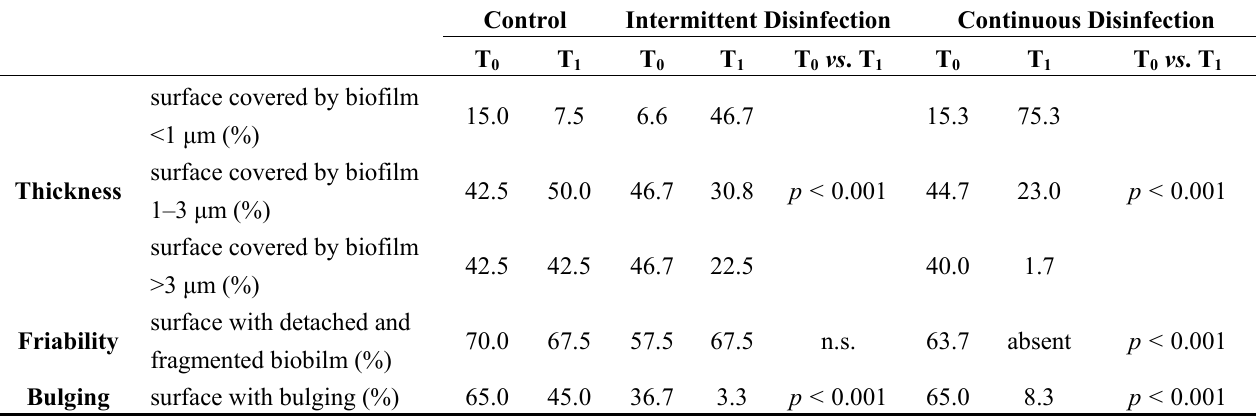
Table 3. Characteristics of the biofilm in relation to the disinfection protocol.